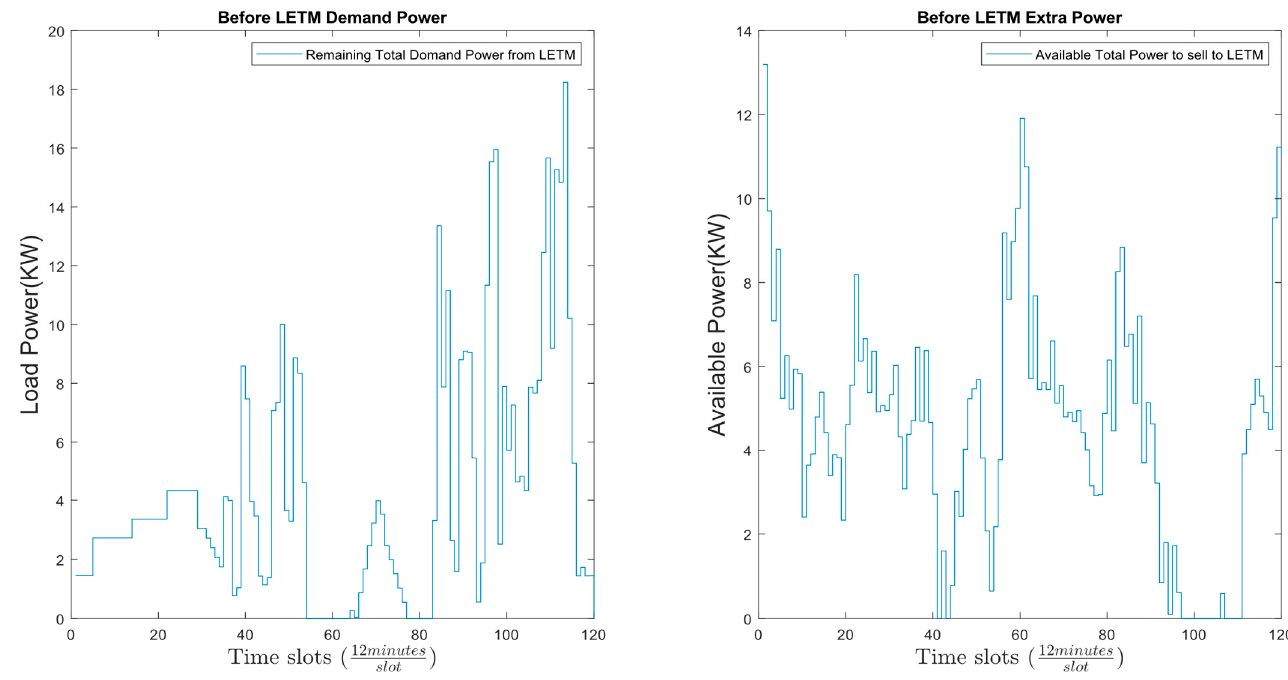
Energies 2023 , 16 , x FOR PEER REVIEW Figure 11. Power demand and surplus before LETM for unscheduled load. Figure 11. Power demand and surplus before LETM for unscheduled load.